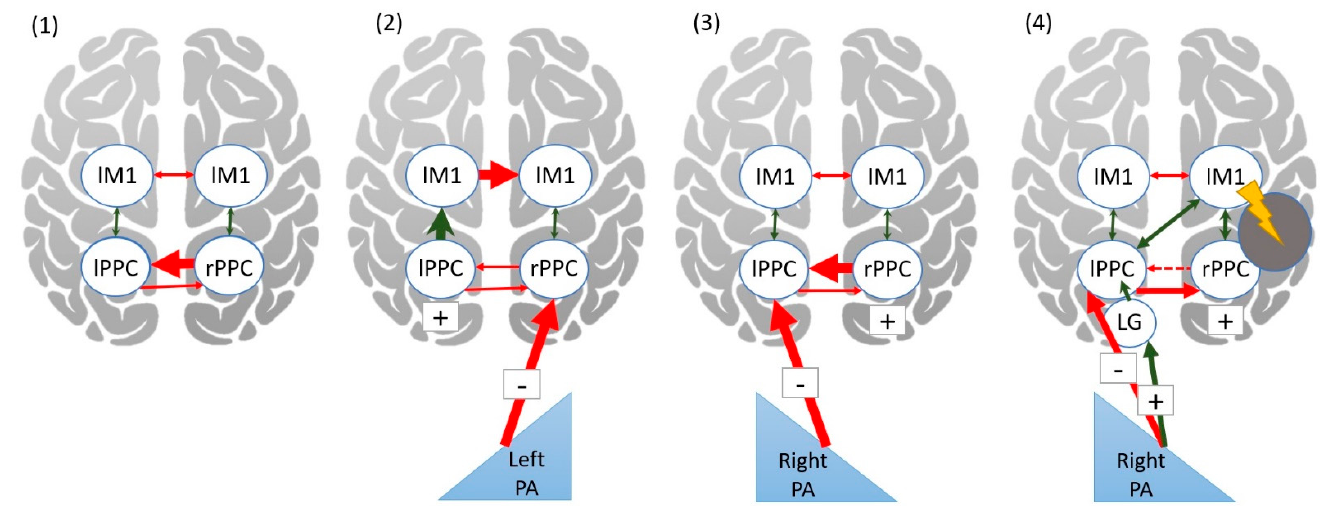
Figure 4. Hypothetical effects of PA in healthy adults ( 1 – 3 ) as proposed by Martín-Arévalo et al. (2018) [87] and in RBD patients ( 4 ). Inhibitory connections are shown in red; excitatory connections are shown in green. Under normal vision, right PPC inhibits the left. PA inhibits contralateral PPC. Following left PA, right PPC is inhibited, which disinhibits the left PPC and propagates activation to left M1, which in turn increases the inhibition of right M1. Following right PA, the inhibition of left PPC by right PPC is maintained. Following RBD, inhibition of left by right PPC is disrupted, the inhibition of left PPC by right PA is mediated by the left visual cortex, left PPC subsumes dominance in spatial orienting. M1—primary motor cortex, PPC—posterior parietal cortex, LG—lingual gyrus.